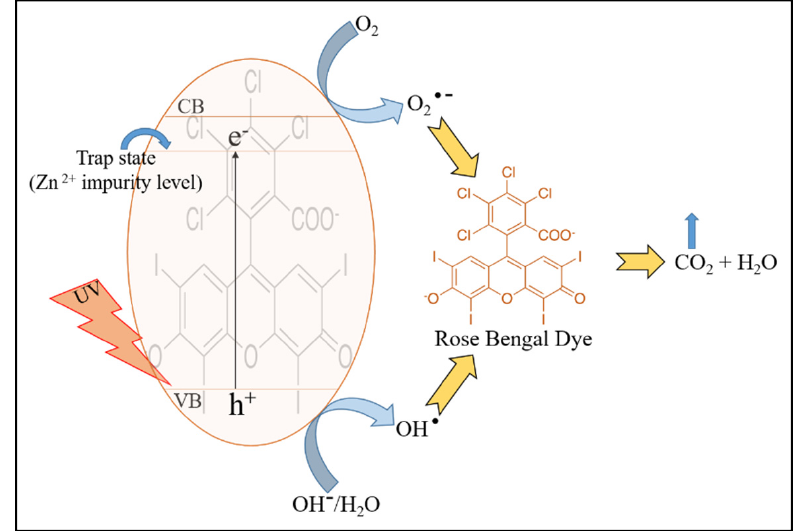
Figure 7. Proposed photocatalytic mechanism in α -Fe 2 O 3 for degrading RB dye. Crystals 2020 , 10 , x FOR PEER REVIEW